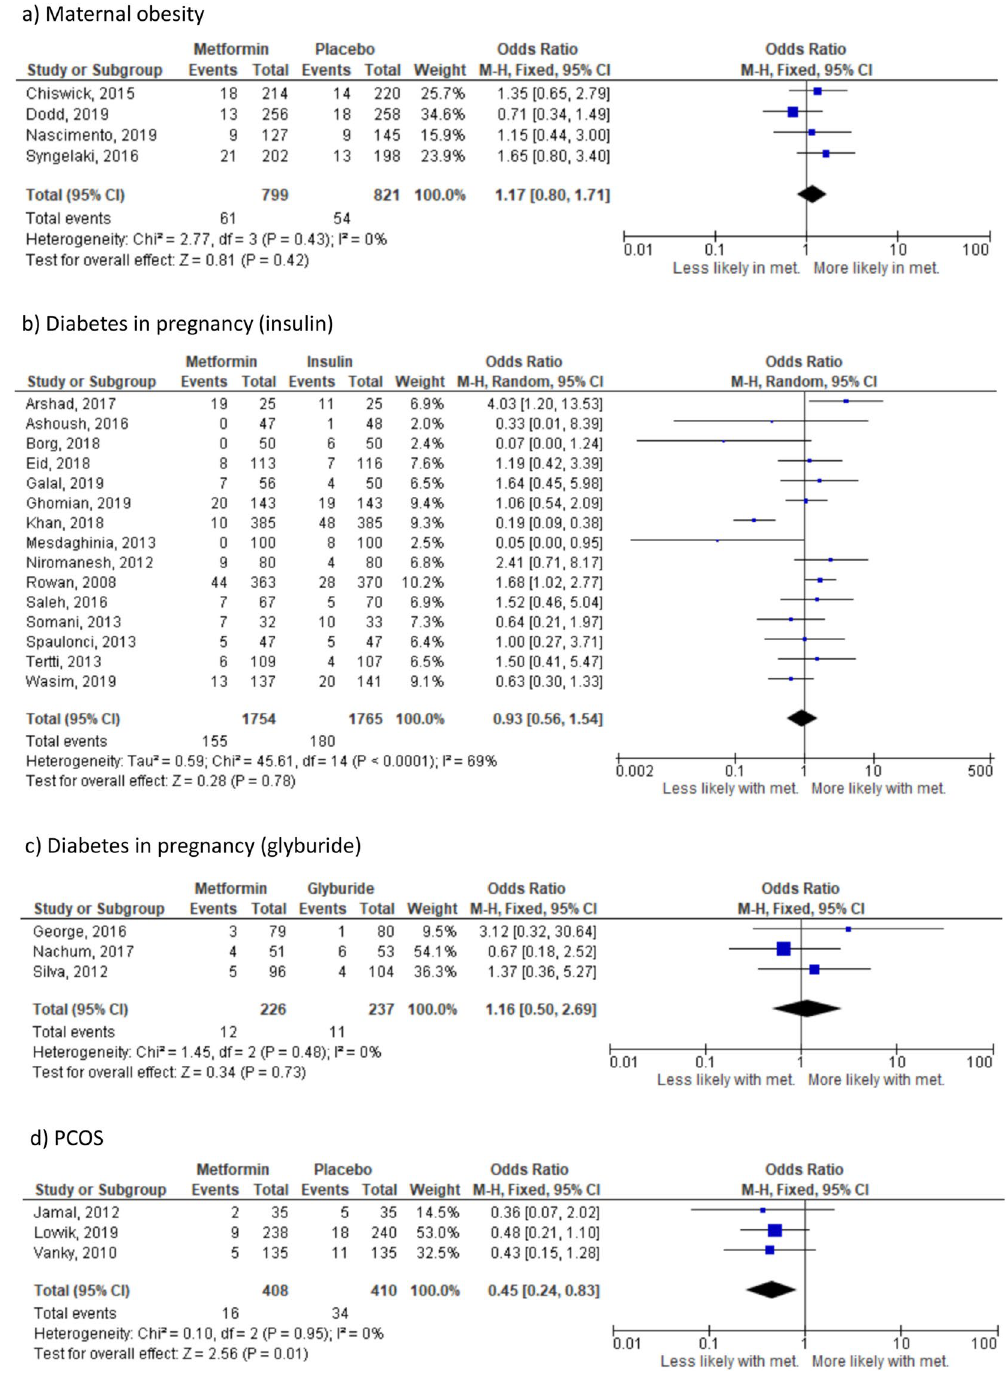
Figure 4. Effect of metformin randomisation upon pre-term birth (all indications). ( a ) All-cause (based on 27 studies including 6959 pregnancies), ( b ) spontaneous (based on 4 studies including 2308 pregnancies) and ( c ) iaotrogenic (based on 5 studies including 2050 pregnancies). Odds ratio, (95% CI). Fixed-effects model for ( a ) and ( b ), random-effects model for ( c